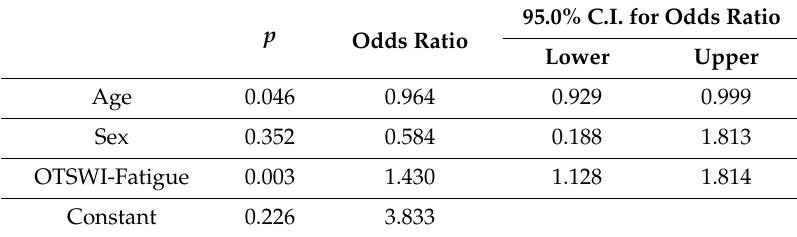
Table 7. Logistic Regression Predicting Likelihood of Reporting Poor psychological well-being among 79 heart recipients one to five years after heart